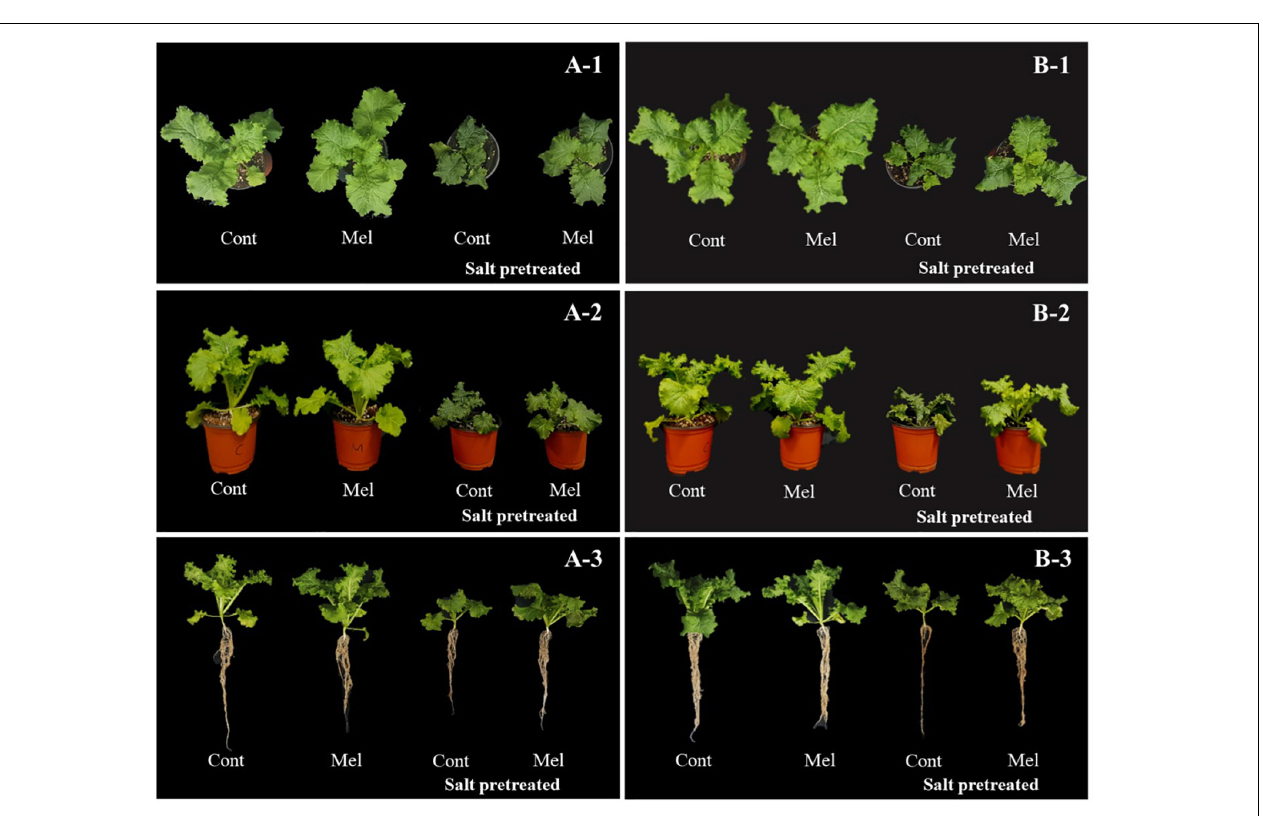
FIGURE 3 | Effect of melatonin with/without salt stress on green mustard growth during four (4DAT; A-1–3 ) and eight (8DAT; B-1–3 ) days. Treatment: control + water, control + 1 µ M melatonin, 150 mM salt pre-treatment + water, 150 mM salt pre-treatment + 1 µ M melatonin.